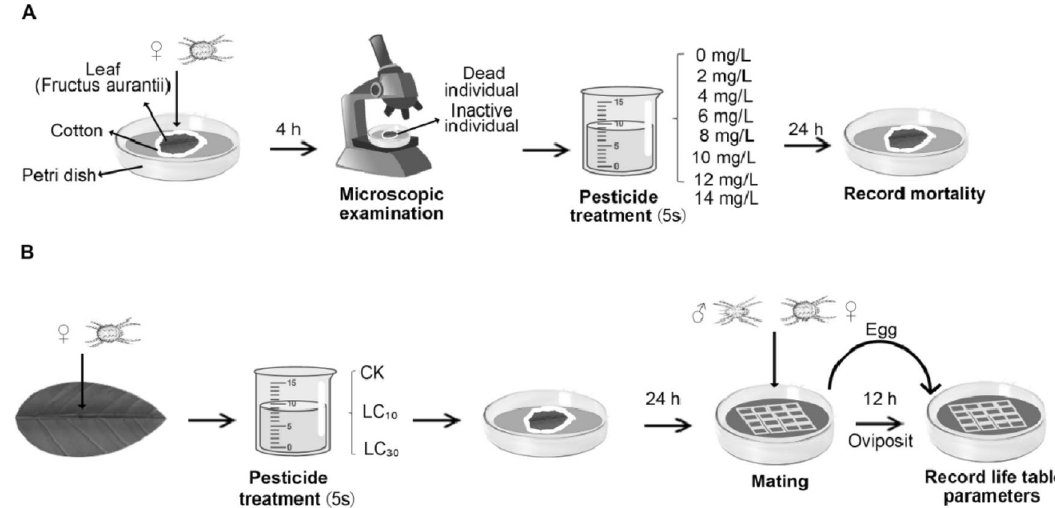
Figure 1. ( A ) Schematic diagram of bioassay method for bifenazate solution with eight concentrations. ( B ) Life table observation of female adults of Panonychus citri in three treatments (CK, LC 10 , LC 30 ). Figure is drawn by Hongyan Wang with Photoshop2020 (https:// www. adobe. com/ produ cts/ photo shop.